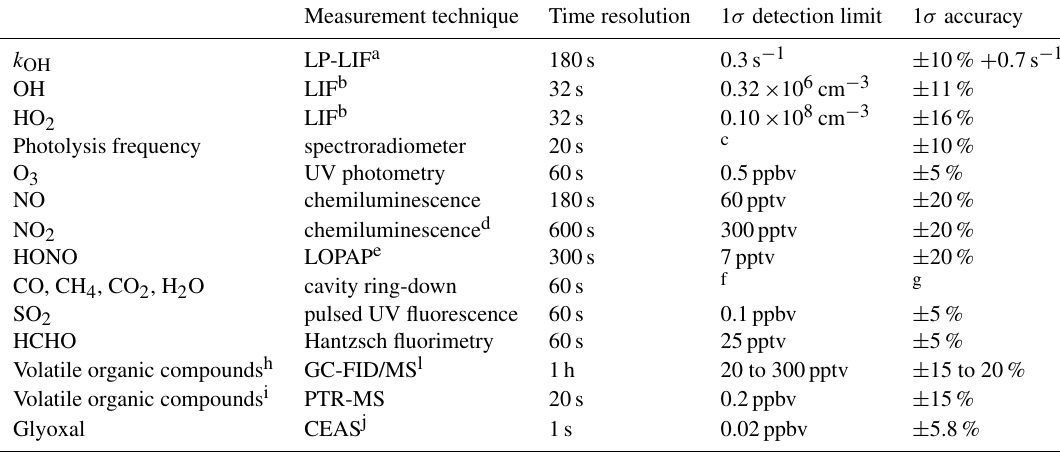
Table 1. Instruments deployed in the campaign and used for data